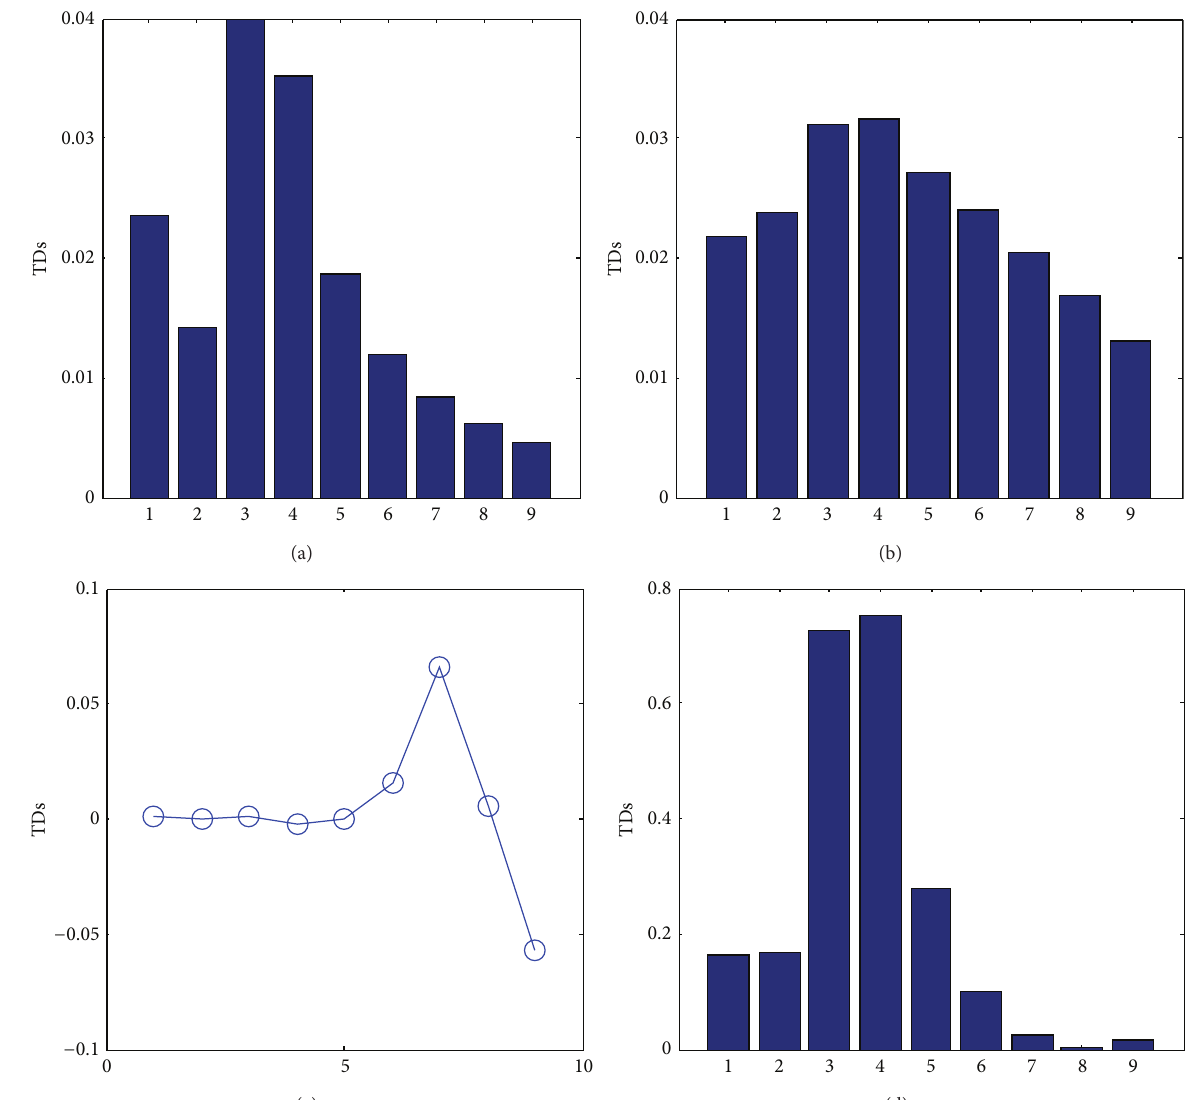
Figure 10: Detection indicators of the cantilever beam when 𝛾 = 0 . 2 with frequency band of 0–10 Hz: (a) this paper, (b) Schulz et al. [4], (c) magnitude value of Zhang et al. [6], and (d) Johnson and Adams